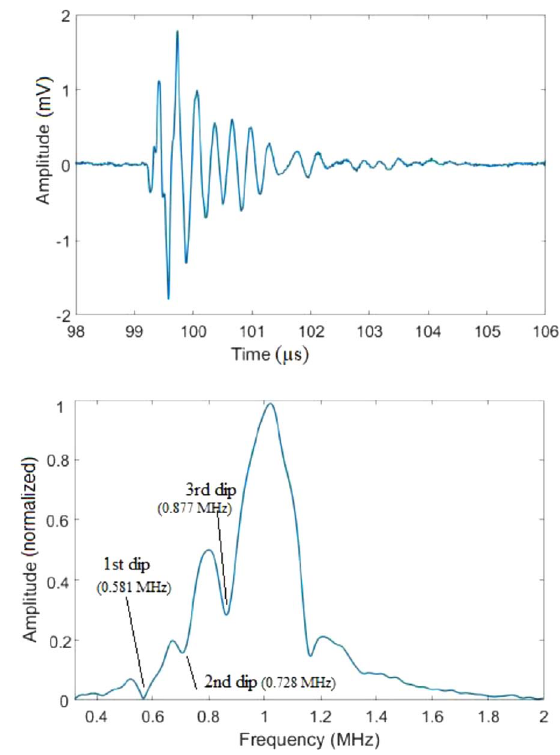
Figure 5. (Top) The waveform of the specular re fl ection along the Y -axis when the sample was under 7.5% strain. (Bottom) The normalized spectrum of the waveform is shown in the top sub fi